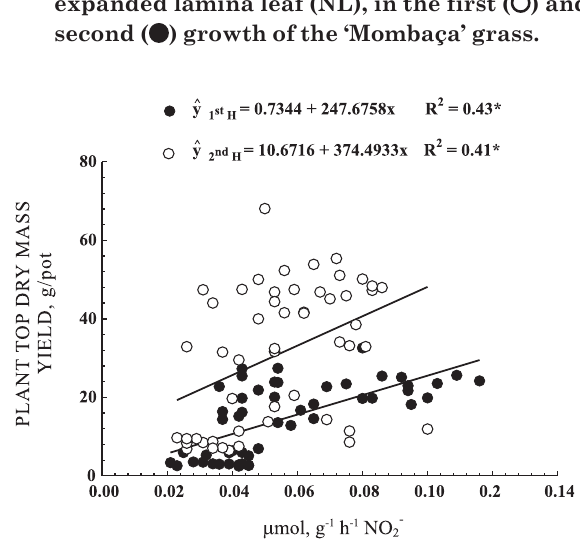
Figure 8. Relationship between plant top dry mass yield and nitrate reductase activity taken on the newly expanded lamina leaf (NL), in the first ( ) and second ( ) growth of the ‘Mombaça’